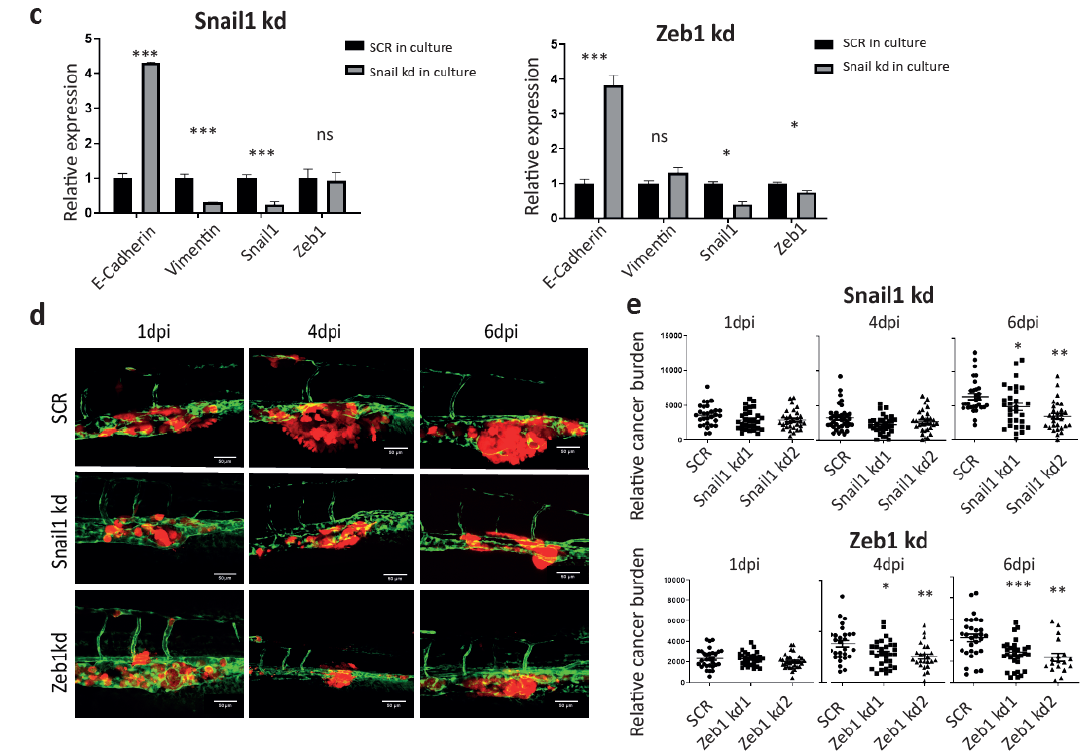
Figure 5. Cripto drives the metastatic phenotype through controlling EMT plasticity. ( a ) PC-3M-Pro4- mCherry-SCR and PC-3M-Pro4-mCherry Cripto kd were injected into ZF. Confocal images were acquired at 6 dpi. Green, vessels. Red, cancer cells. Scale bar = 50um. Cancer cell burden at the metastatic site was quantified by measuring total fluorescence intensity at 6 dpi. Group size = 30. ( b ) Expression of Cripto, stemness markers and EMT markers was measured in PC-3M-Pro4-mCherry- SCR and PC-3M-Pro4-mCherry-Cripto kd in culture and in ZF metastases at 6 dpi. Experiments were independently repeated three times. Data were presented as mean ± SD ( c ) Expression of EMT markers was compared between PC-3M-Pro4-mCherry-SCR, -Snail1 kd and -Zeb1 kd. Experiments were independently repeated three times. Data were presented as mean ± SD ( d ) PC-3M-Pro4-mCherry-SCR, -Snail1 kd and -Zeb1 kd were injected into ZF. Confocal images were acquired at 1, 4 and 6 dpi. Green, vessels. Red, cancer cells. Scale bar = 50um. ( e ) Cancer cell burden at the metastatic site was quantified by measuring total fluorescence intensity. Group size = 30. Data were presented as mean ±